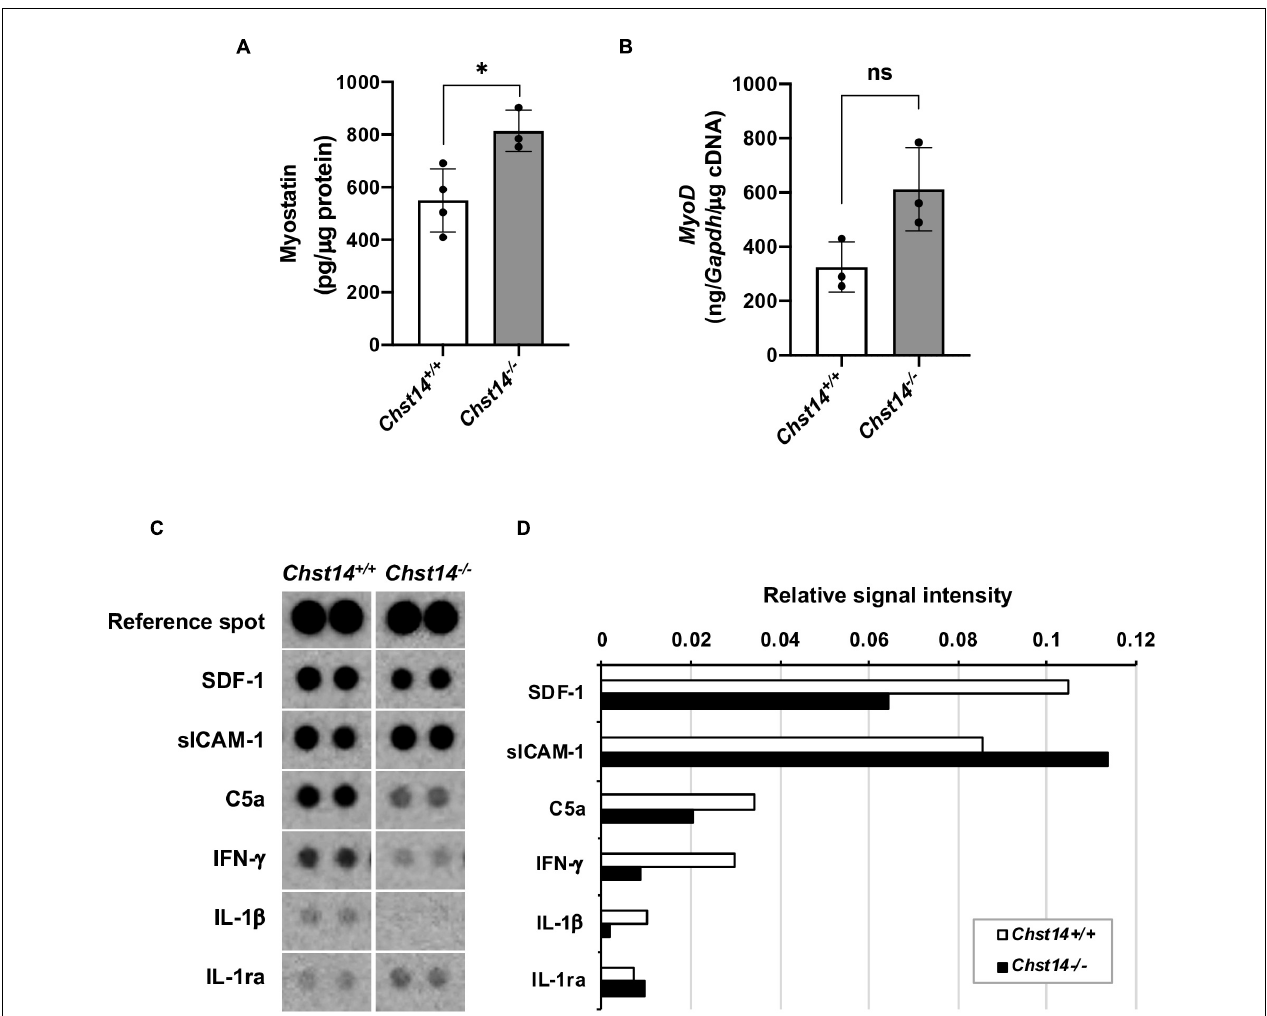
FIGURE 2 | Expression of myogenesis-associated factors and myokines/chemokines in DS-deficient muscle. (A) Quantitative measurement of myostatin expression (pg/ µ g protein) in the muscle lysate using an enzyme-linked immunosorbent assay (ELISA) (* p < 0.05). (B) Quantitative measurement of MyoD mRNA in the muscle from 1-year-old sex-matched Chst14 + / + ( n = 8) and Chst14 − / − ( n = 4) mice by quantitative real-time PCR were normalized with Gapdh (ng/ Gapdh / µ g cDNA). Data are presented as mean ± standard deviation, and there was no statistical difference between Chst14 + / + and Chst14 − / − by t -test. (ns, not significant). (C) Cytokine and chemokine expression in the muscle from 1-year-old sex-matched Chst14 + / + ( n = 3) and Chst14 − / − ( n = 3) mice were analyzed using the Proteome profiler TM array. Images of dot signals showed changes in the expression levels of stromal cell-derived factor 1 (SDF-1), soluble intercellular adhesion molecule-1 (sICAM-1), complement component 5a (C5a), interferon- γ (IFN- γ ), IL-1 β , and IL-1ra, compared to the reference spot signals. (D) Relative signal intensity correlated by reference spot signals in the array images were quantified using Image Quant TL